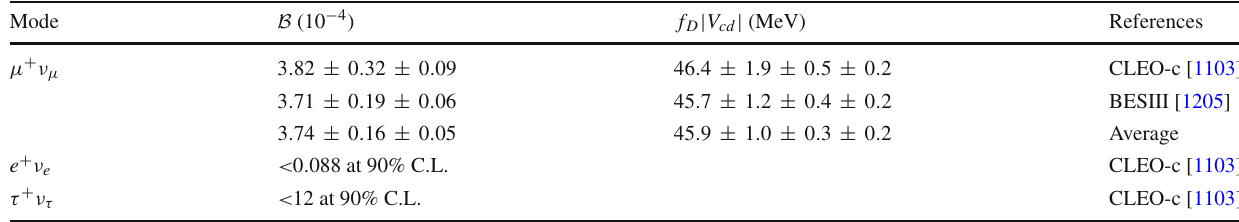
Table 282 Experimental results and world averages for B ( D + → (cid:12) + ν (cid:12) ) and f D | V cd | . The first uncertainty is statistical and the second is experimental systematic. The third uncertainty in the case of f D + | V cd | is due to external inputs (dominated by the uncertainty of τ D )